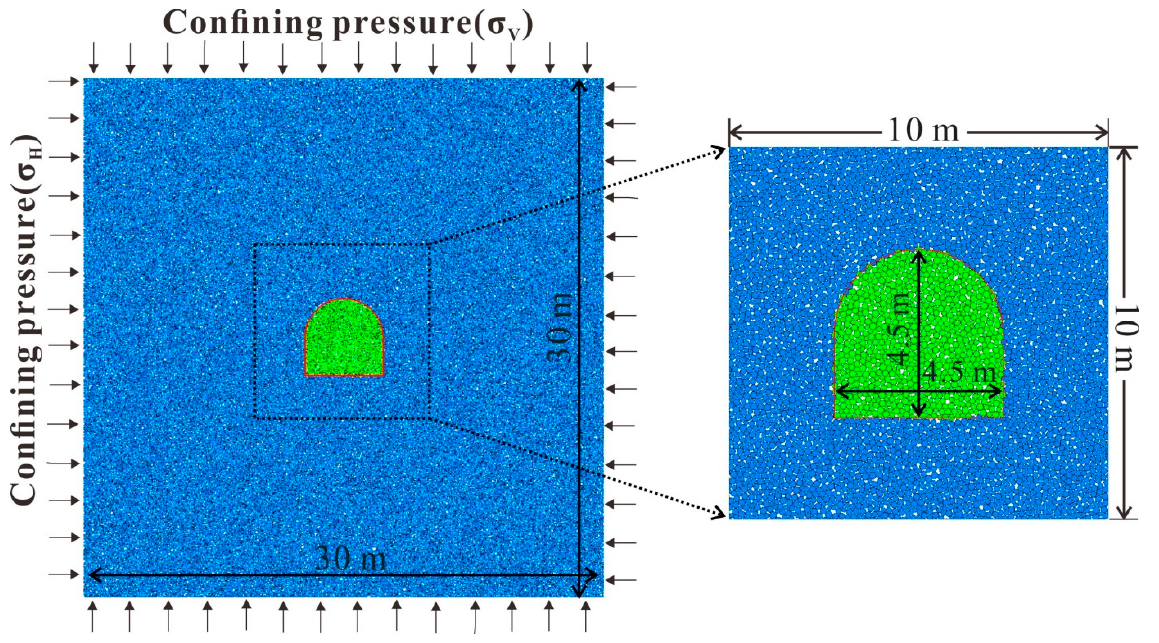
Figure 4. The simulation model.